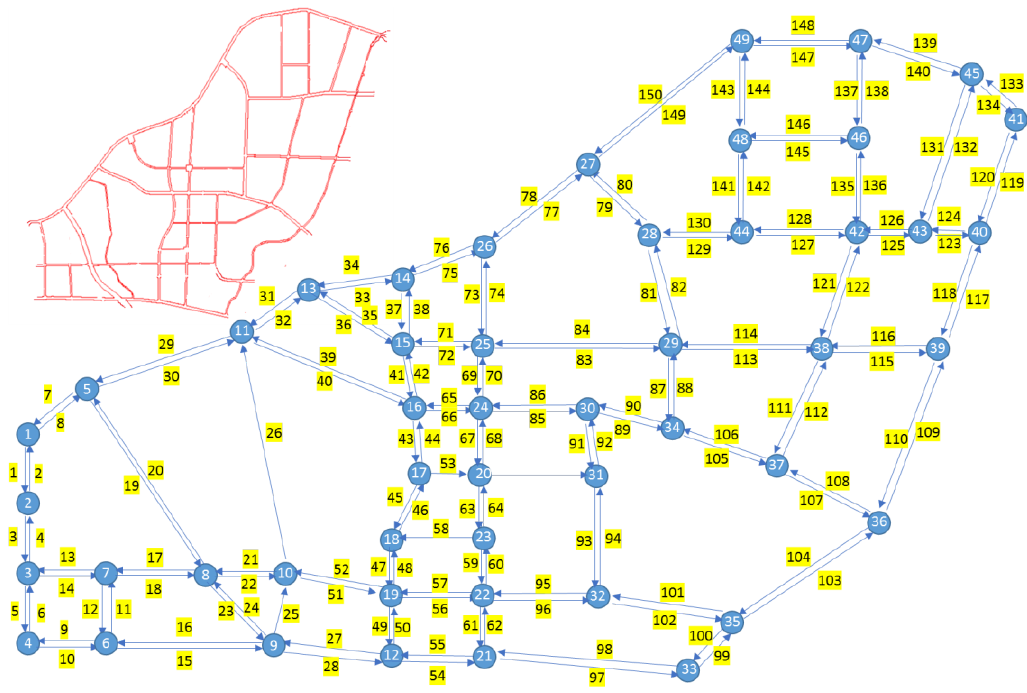
Figure 5. The real network of case study showing topology, links with scanning sensors and links with counting sensors.